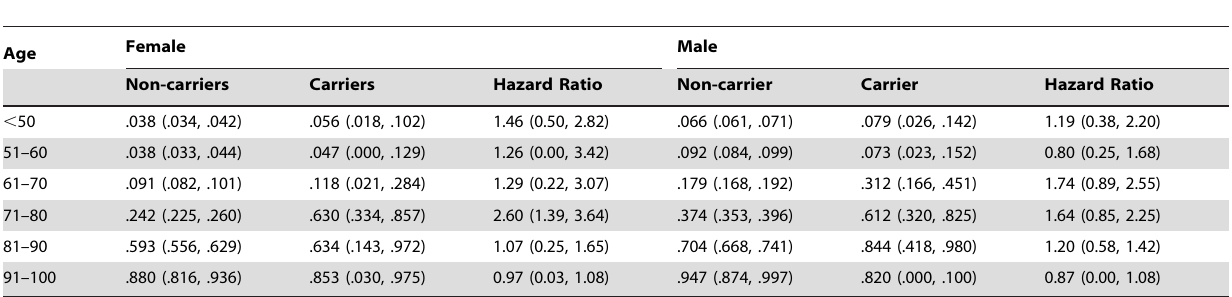
Table 2. Estimated hazard of mortality due to carrying a BRCA mutation in the absence of melanoma and cancer of the breast, ovary, pancreas, and prostate 1